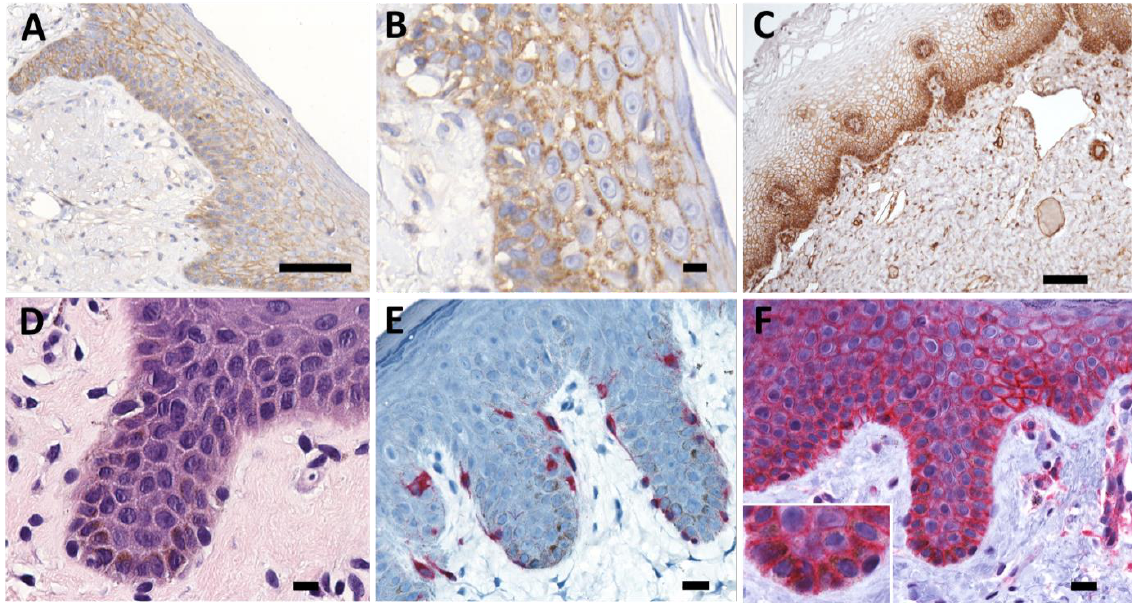
Figure 1. PMCA4b expression in human skin and mucosa. ( A , B ) In the skin, PMCA4b expression is increasing from the basal cells to the stratum spinosum and granulosum. The PMCA4b staining pattern resembles desmosomal localization. ( C ) In the vaginal mucosa, basal cells have the highest PMCA4b expression. ( D – F ) The hematoxylin-eosin staining of the vulval epidermis shows a high number of pigment containing cells. ( E ) Melan-A staining (red) identifies the melanocytes in the basal cell layer that are characterized by a distinct nuclear morphology. ( F ) The plasma membrane between melanocytes and basal cells stained for PMCA4, whether the proteins are localized on the melanocytic plasma membrane as well cannot be unequivocally determined. Scale bars: ( A , C ): 100 µm; ( B ), ( D – F ): 10 µm.